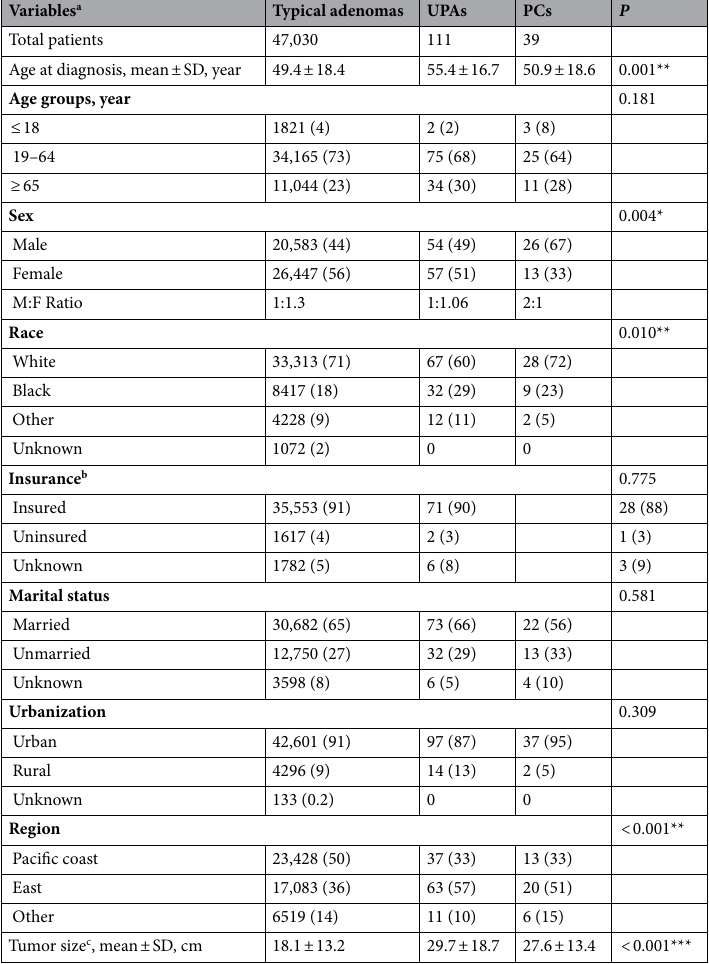
Table 1. Demographic and clinical characteristics of patients included in the present study. UPAs Uncertain behavior pituitary adenomas, PCs Pituitary carcinomas. a Data were presented in numbers and percentages unless noted otherwise, unknown status was no included in statistical comparisons. b For cases registered 2007 and onward. c Only cases with exact tumor size recorded were calculated (n = 36,732). * P value for